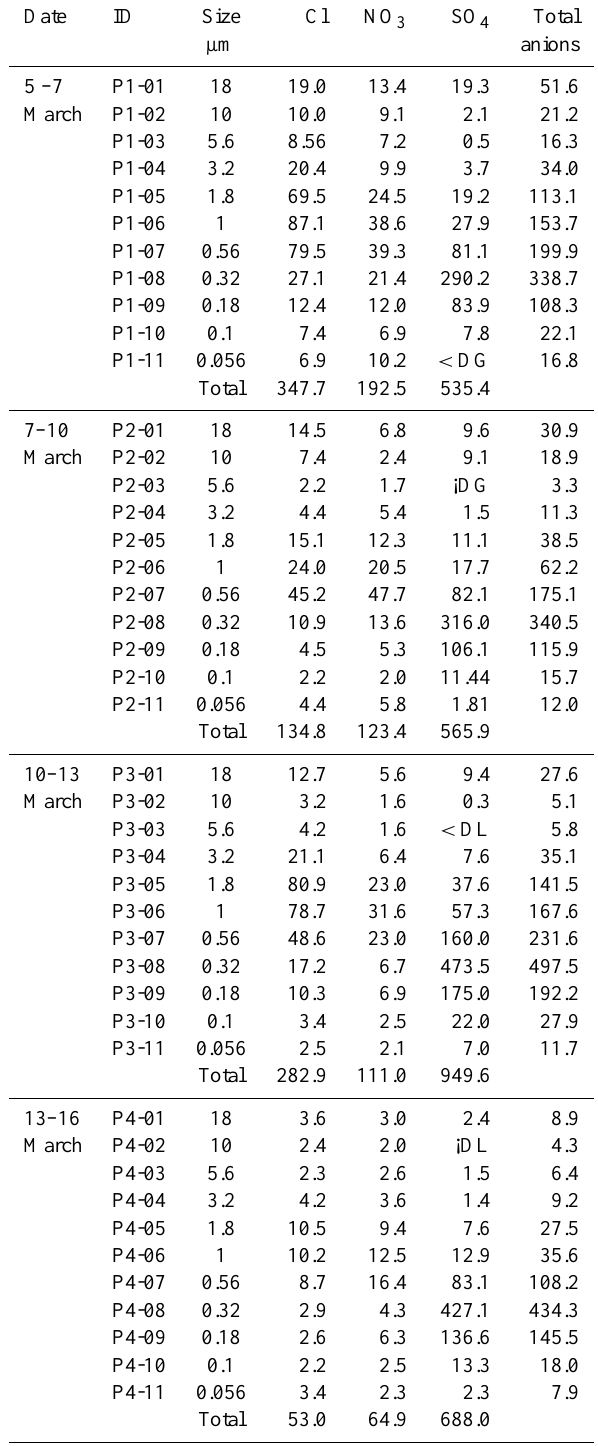
Table 1. Concentrations (ngm − 3 ) of ions in the size-segregated aerosol